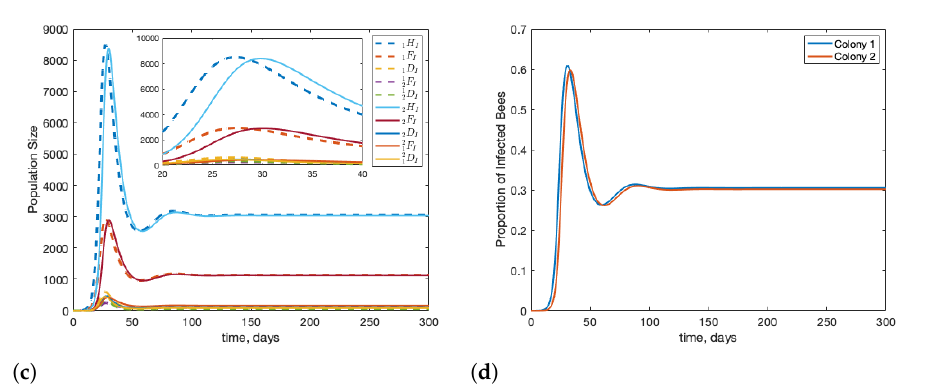
Figure 6. Beginning from equilibrium, we introduce one infected forager into colony 1 ( 1 F I ( 0 ) = 1). In this scenario, we allow healthy foragers and drones to drift between colonies, but infected bees are detected and are removed. In panels ( a , b ), we assume there is a perfect filter for infected hive bees; in panels ( c , d ), we assume this guarding behaviour is 50% effective.